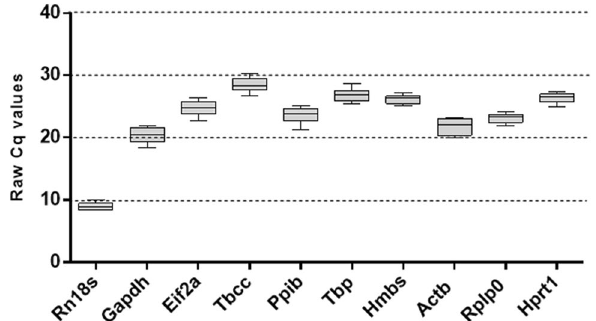
Figure 1. Quantification Cycle (Cq) values of the reference genes across all samples. Box plot for each reference gene representing the interquartile range, median, and the upper and lower range of raw quantification cycle values (Cq) across all